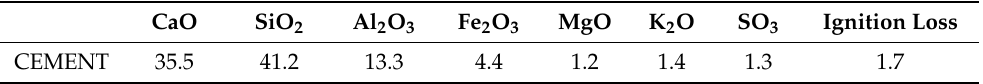
Table 1. Cement chemical composition (%wt.).